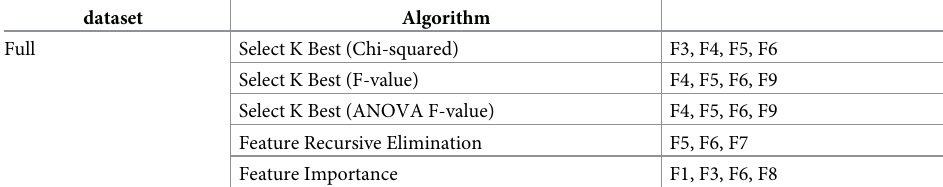
Table 10. Results of feature selection of the breast-cancer